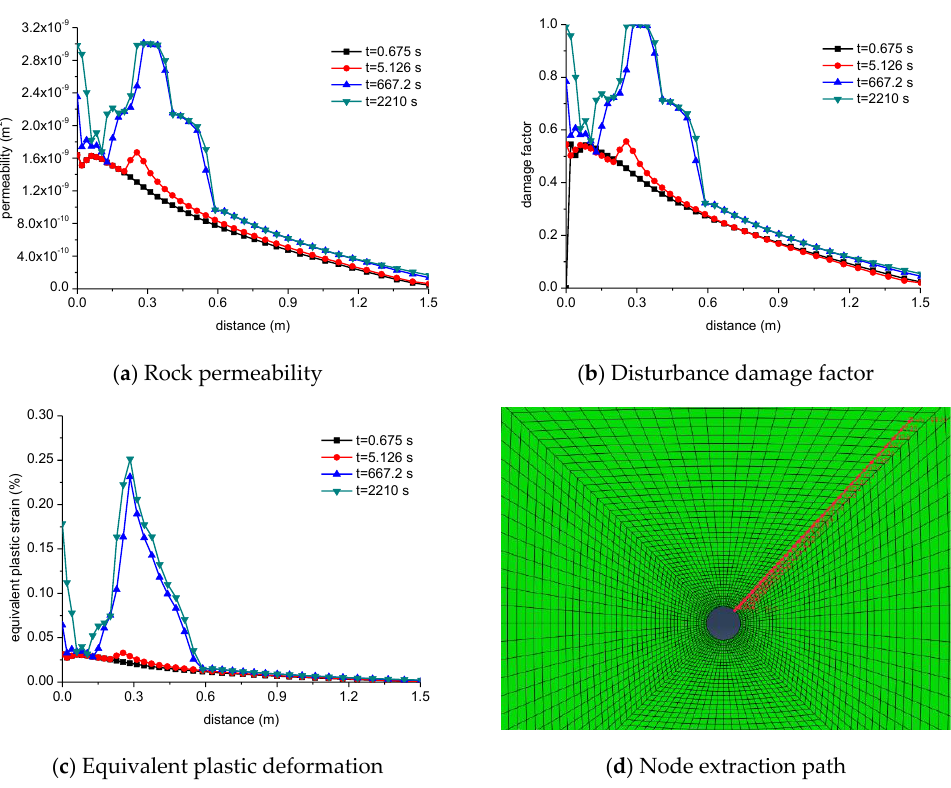
Figure 5. Rock permeability, disturbance damage factor, and equivalent plastic strain with different distances from the borehole.